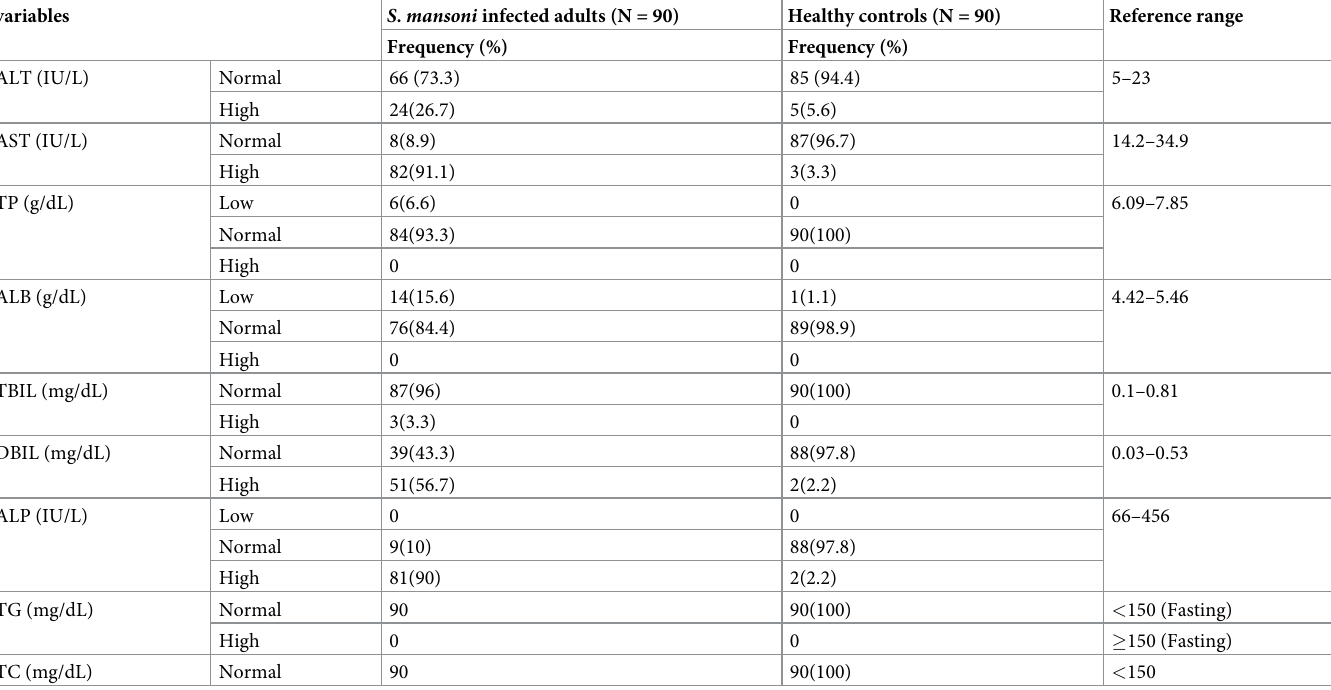
Table 3. Biochemical profiles of S . mansoni infected adults and healthy controls at Haik Primary Hospital, North-East Ethiopia, from February to April 2021.